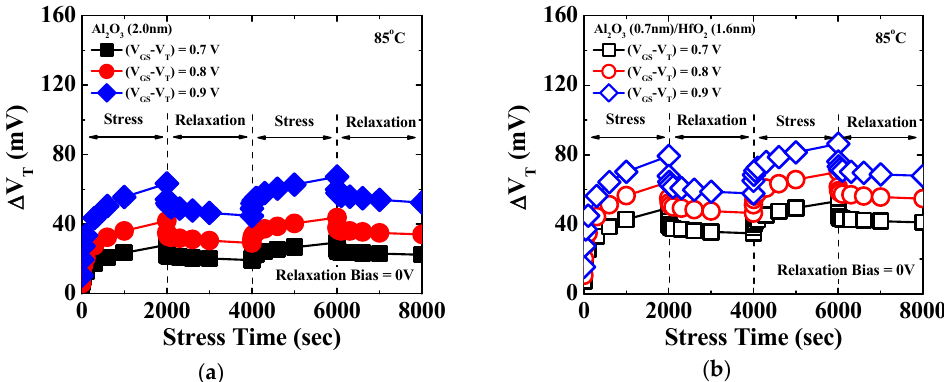
Figure 2. Comparison of charge trapping and relaxation characteristics in In 0.7 Ga 0.3 As metal oxide semiconductor field-effect transistor (MOSFET) with ( a ) single-layer Al 2 O 3 and ( b ) bi-layer Al 2 O 3 /HfO 2 gate stacks under PBT stress at different overdrive conditions.